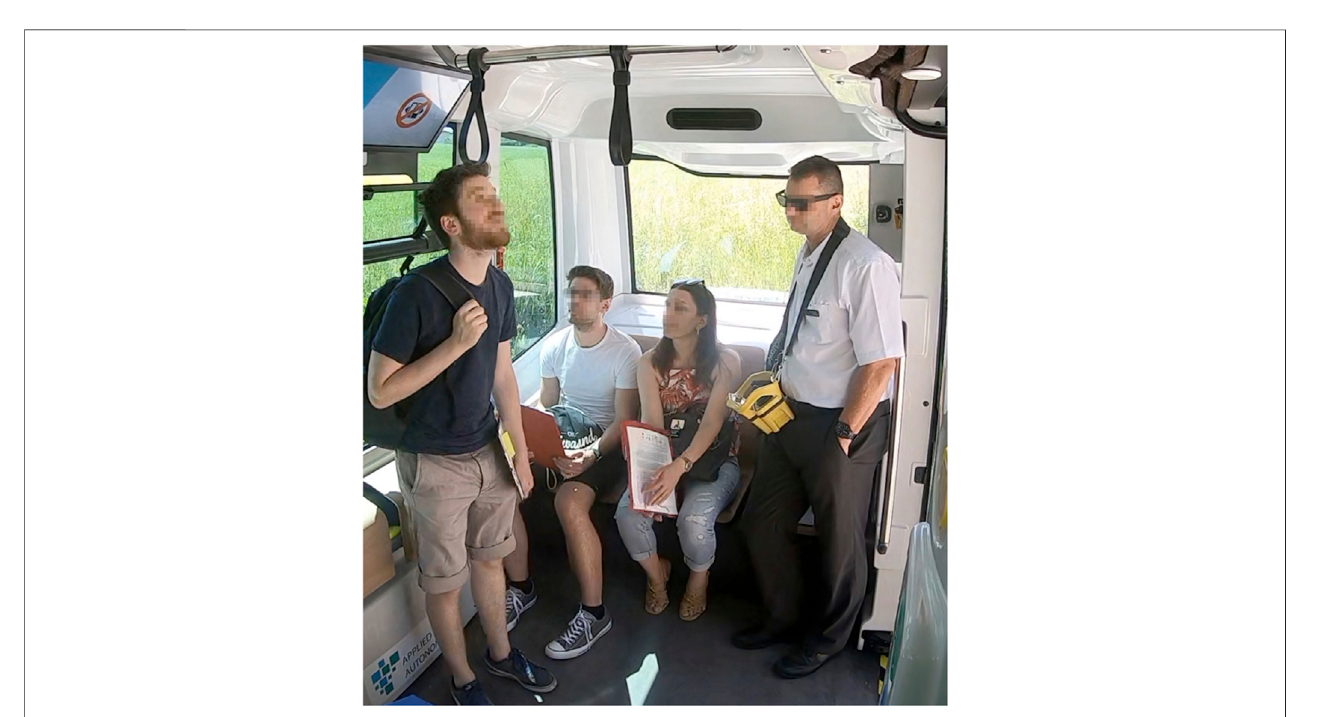
Frontiers in Human Dynamics |